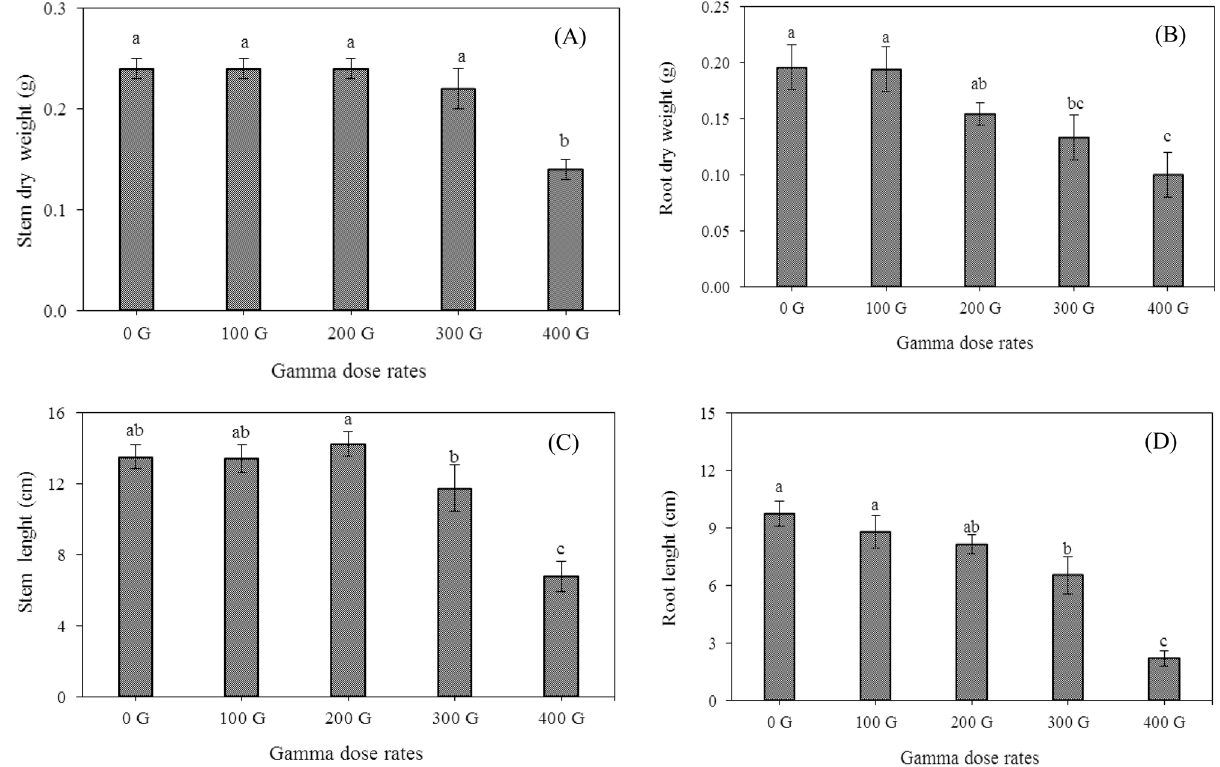
Figure 2. Effects of gamma dose rates on stem dry weight ( A ), root dry weight ( B ), stem length ( C ), root length ( D ). Each bar represents mean ± SE (n = 3). Mean values marked with different letters are significantly different (p ≤ 0.05) by LSD